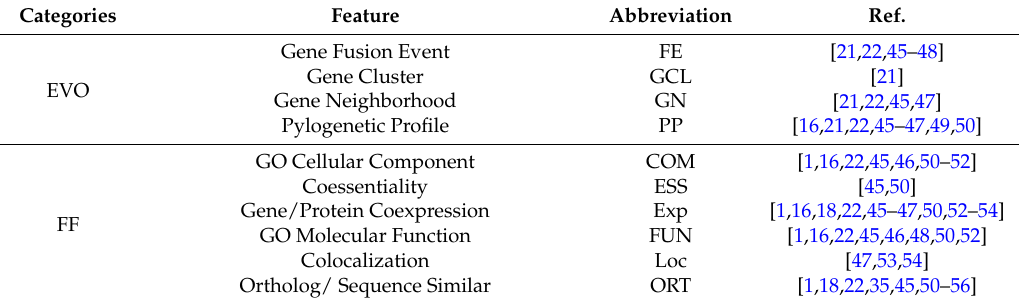
Table 2. Annotated protein pairs with diverse